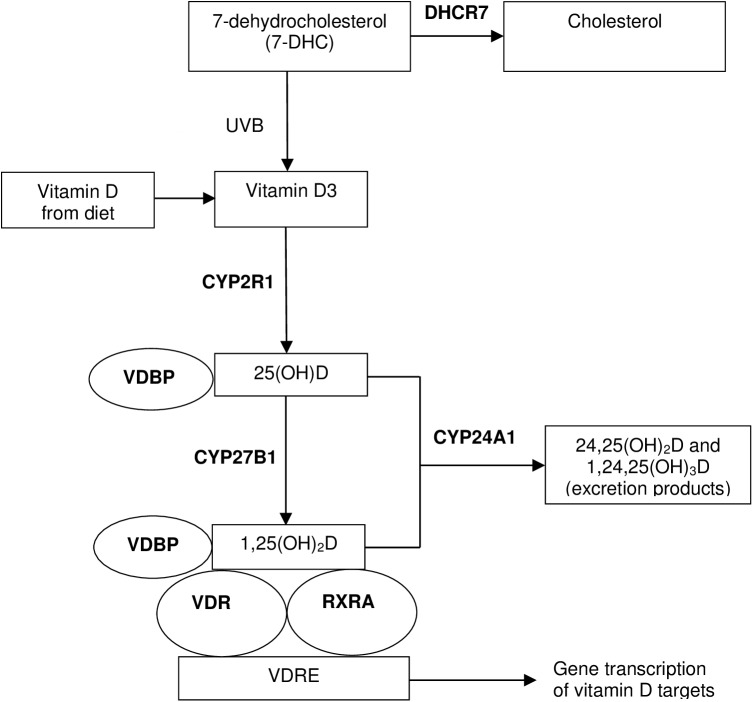
Vitamin D pathway.Vitamin D3 (cholecalciferol) is produced in the skin from UV photoconversion of 7-dehydrocholesterol (7-DHC), which can be converted to cholesterol through a process mediated by 7-dehydrochlesterol reductase (DHCR7), or obtained through diet. Vitamin D3, as well as vitamin D2 from plant sources and dietary supplements, is metabolized in two hydroxylation steps. The first hydroxylation occurs in the liver largely by CYP2R1-mediated 25-hydroxylase action to form the most abundant circulating metabolite, 25(OH)D [7] and the second in the kidney, breast, and other tissues by CYP27B1 to form the active metabolite, 1,25(OH)2D [8, 9]. The molecular actions of 1,25(OH)2D occur upon its binding to the vitamin D receptor (VDR), prompting the association of the VDR with the retinoid X receptor alpha (RXRA), to activate or suppress transcription of downstream gene targets. 25(OH)D and 1,25(OH)2D are broken down into 24-hydroxylated products by CYP24A1 and targeted for excretion [10]. Vitamin D and its metabolites are bound with varying affinities and transported in the circulation by the vitamin D-binding protein (VDBP) [11–13].